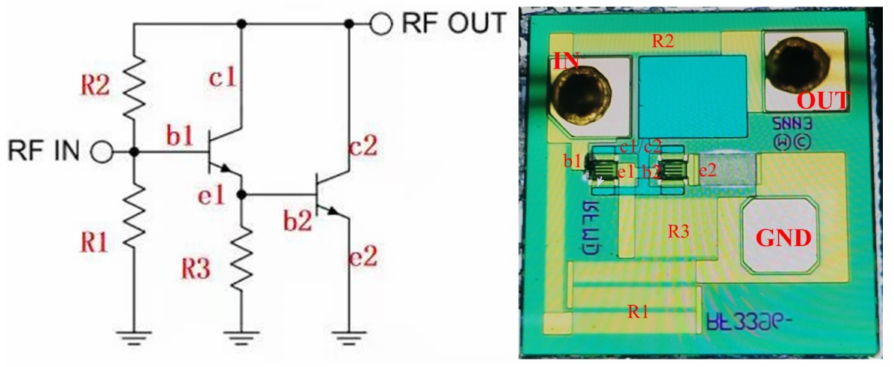
Figure 9. Schematic diagram of the circuits in the